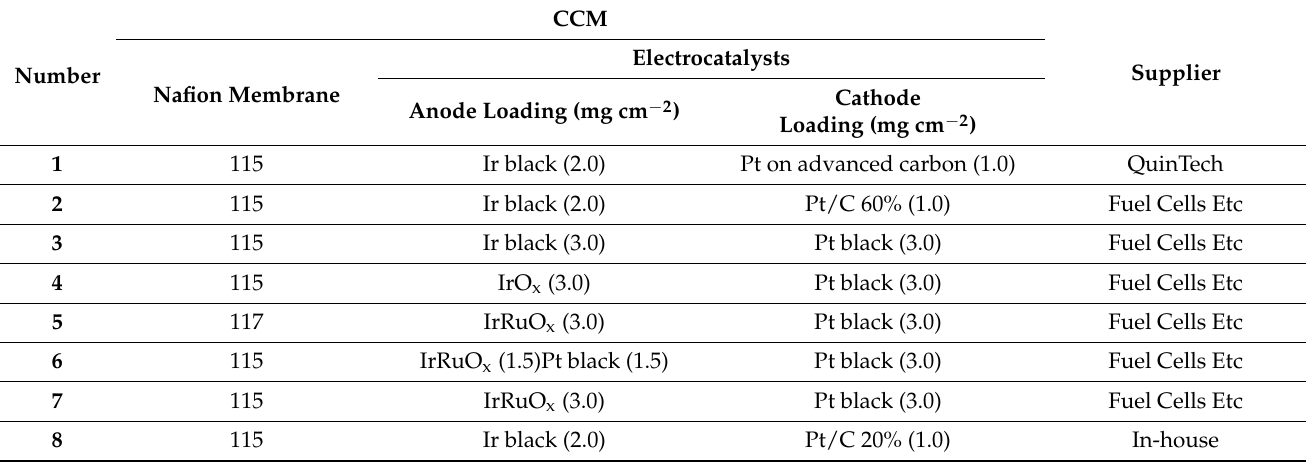
Table 1. Characteristics of the CCMs tested in this